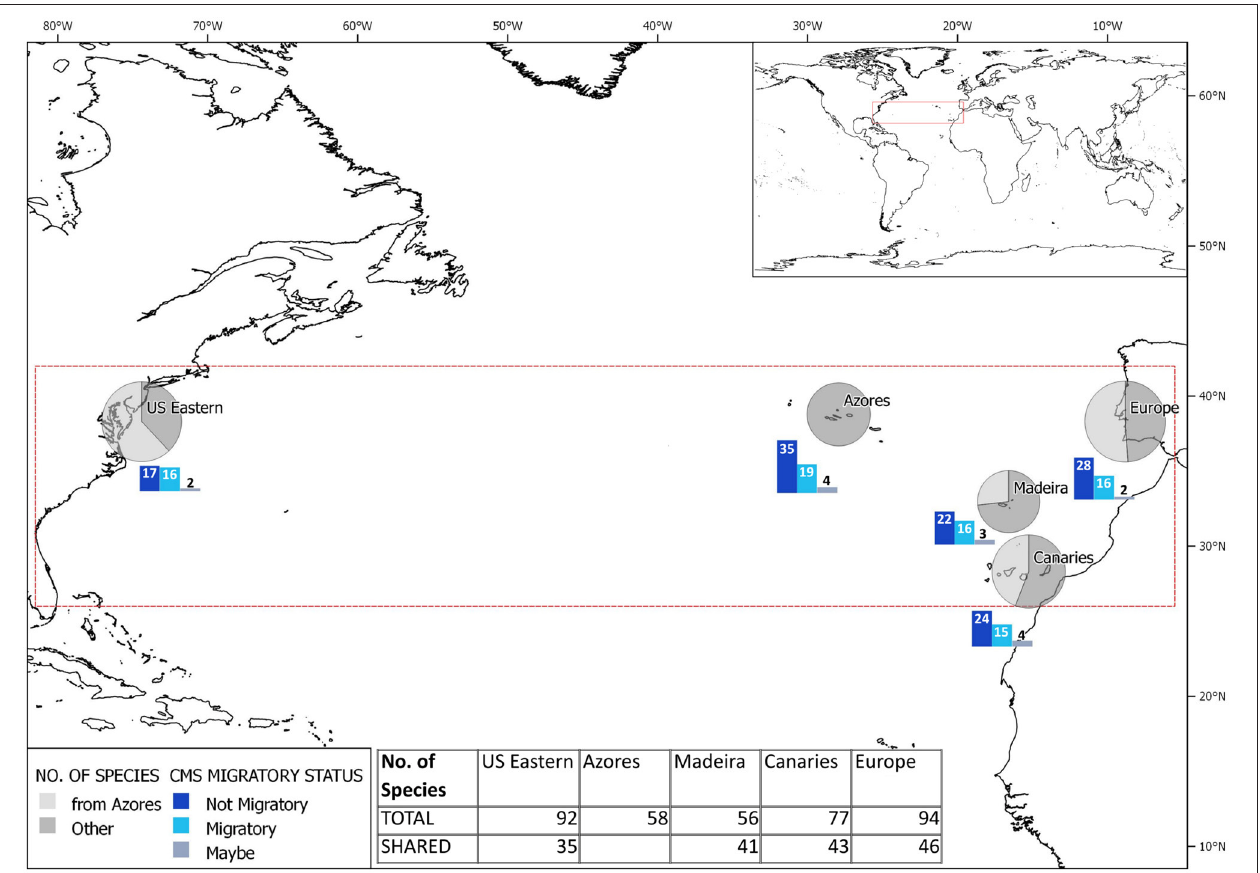
FIGURE 1 | Distribution of species shared between the Azores and the study regions in the North Atlantic, and their currently known migratory status. The size of the circles are relative to total species diversity.